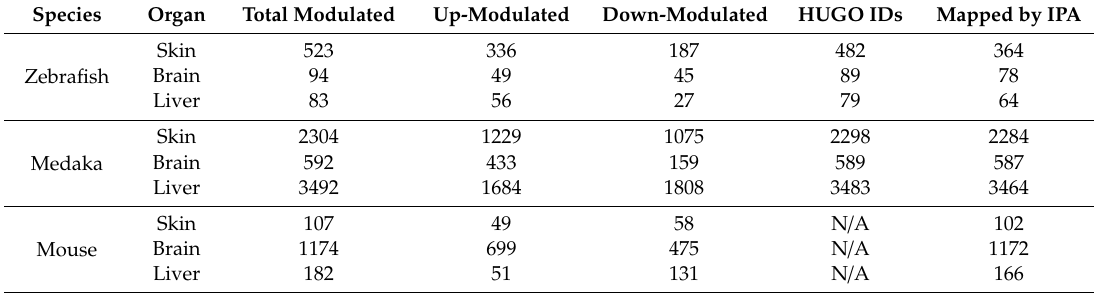
Table 1. Di ff erentially expressed genes for fluorescent light (FL) exposed samples. Total modulated genes are the output file from EdgeR (column 2) that had a log 2 (fold change) ≥ | 2.0 | and a ( p -adj < 0.05). All fish Ensembl IDs were converted to Human Genome Organization (HUGO) IDs (column 5) for Ingenuity Pathway Analysis (IPA) analysis and direct comparison of the zebrafish, medaka and mouse. HUGO IDs were then imported and mapped by Qiagen’s IPA software for functional and pathway analysis (column 6). Mouse Ensembl IDs were directly imported into IPA for functional and pathway